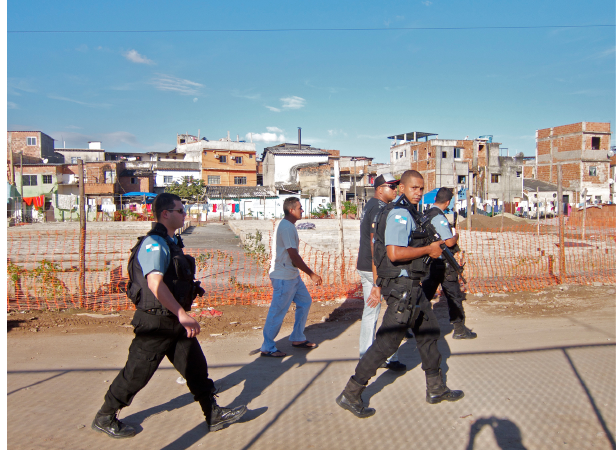
Figure 2. UPP patrol, Manguinhos favela,